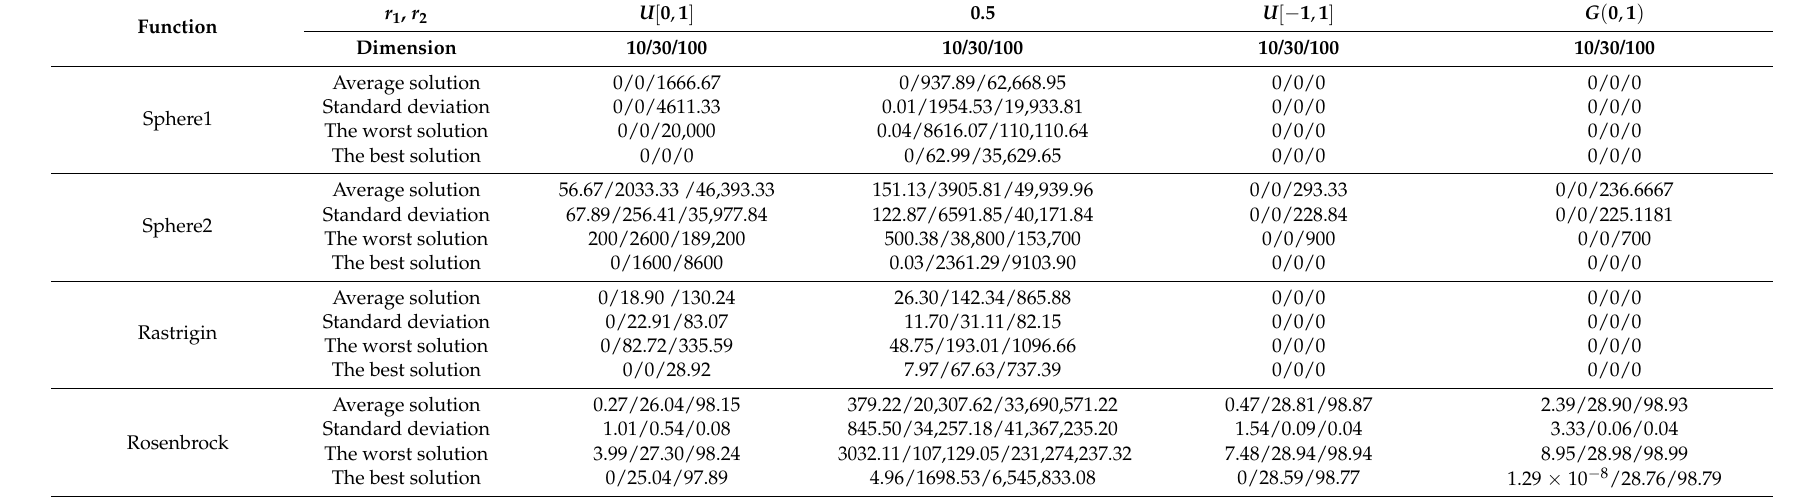
Table 3. Comparisons of LDIW-PSO algorithm with different types of random values for benchmark